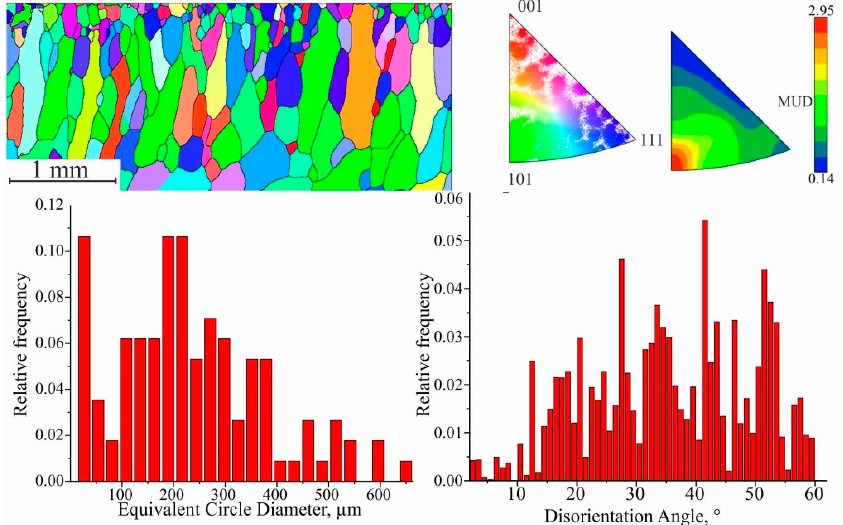
Figure 15. EBSD map fragment; grain size; disorientation; scattered and contoured IPFs for III area. The size of the grains in this region is very close to each other, but the spatial distribution of the places where the new grains emerge is different. Consequently, for orientation <101>, the distance traveled by the boundary to their collision is greater. After collective recrystallization, secondary recrystallization takes place. In this case favorably oriented grains grow, thus forming a crystallographic texture in the material. Grains of this range are characterized by an elongated shape, with an average size d III = (338.54 ± 13.83) µ m. The fraction of low-angle boundaries is insignificant, and twin boundaries are practically absent. Based on the IPF analysis, it is clear that the fraction of preferential orientation increases significantly, and the MUD function value differs by a factor of 25. The direction of recrystallization does not coincide with the vertical direction of the cladding due to the temperature gradient during printing. After the completion of secondary recrystallization, abnormally large, elongated grains are formed, with average length and width values of d IV = (1086.45 ± 57.13) µ m at the beginning of formation; in the finished workpiece, they are up to 3.5 mm and 0.3 mm in length and thickness, respectively (Figure 16). The absence of twin boundaries is characteristic. Grains in this range are characterized by a preferential orientation close to <101> (range between 414 and 134). The temperature gradient plays a key role in the morphology and size of the structure and determines the crystallization mode. During the deposition of the first layers of C11000 copper on stainless steel substrate AISI 304, rapid heat dissipation occurs, which, together with the alloying of copper with austenitic steel components (primarily Fe) and the formation of inclusions of the second phase, leads to the formation of a fine-grained structure. As the blocks grows, the influence of these factors decreases and directional grain growth occurs. Directed grain growth is facilitated by the slow heat dissipation and temperature gradient formed during additive blocks growth (Figure